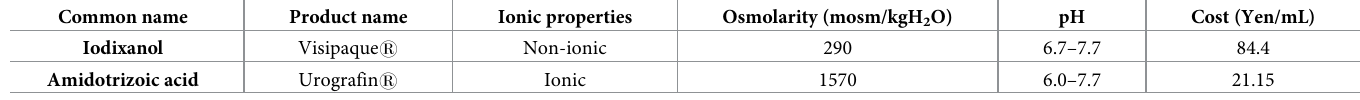
Table 1. A comparison between iodixanol and amidotrizoic